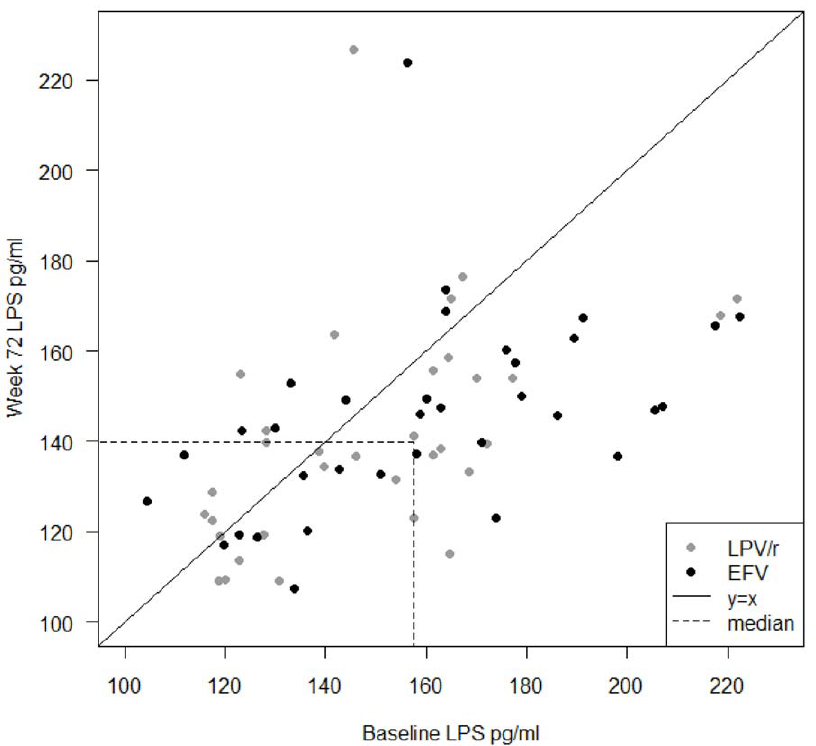
Figure 2. Levels of LPS. Levels of LPS were significantly reduced after 72 weeks of antiretroviral therapy in the whole cohort, with a unified pattern in both treatment arms. Data are shown as individual values with corresponding baseline LPS levels at X-axis and week 72 levels at Y-axis, respectively. Individuals treated with lopinavir (LPV/r) are indicated with shaded and efavirenz (EFV) with black circles. Dotted lines refer to median values at the corresponding